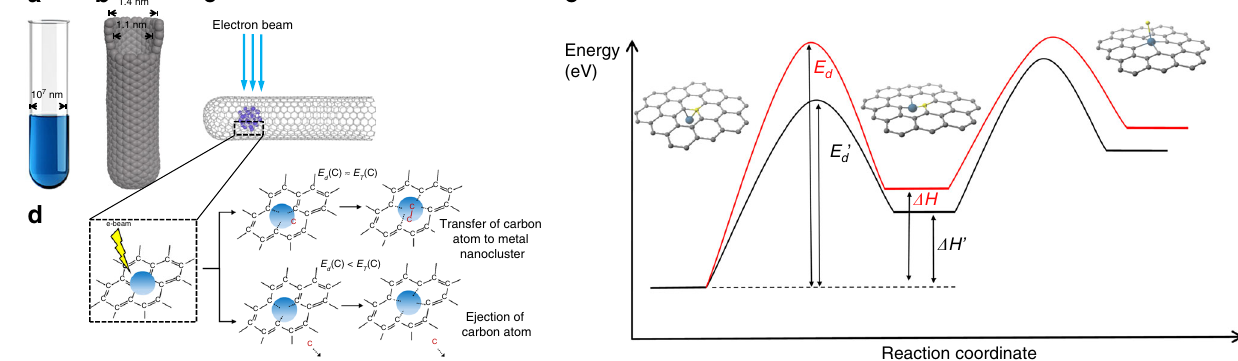
Fig. 1 Fundamental principles of ChemTEM. In comparison to conventional glass test tubes ( a ), which have a diameter of (cid:2) 1 cm (10 7 nm), carbon nanotubes ( b ), possess a channel with a van der Waals diameter of 1.1 nm making them a suitable vessel for the entrapment of nano-sized samples of different chemical elements, that can also act as an effective nanoreactor provided that the nanotube structure is not defective and its inner channel is free of impurities. Our methodology enables the insertion of clusters of 20 – 60 metal atoms within nano test tubes ( c ) and investigation by aberration corrected high resolution TEM (AC-HRTEM) reveals the nanoclusters ’ structures and chemical transformations at the atomic scale. The electron beam serves a dual purpose: some electrons (a tiny fraction) transfer a portion of their kinetic energy to the metal and carbon atoms, as described by the equation for E T above, which activates chemical transformations in the sample, whilst most of the electrons are transmitted through or scattered by the specimen generating two- dimensional images, the collation of which into time series enables the results of the induced transformations to be observed over time. d The presence of metal nanoclusters reduces the energy barrier for the displacement of a carbon atom ( E d ) from the nanotube which can be either ejected, leading to a vacancy defect (bottom diagram) or converted into another carbon structure (top diagram), with both processes facilitated by the metal nanocluster (Supplementary Fig. 9). e A schematic energy pro fi le of the formation of a vacancy defect illustrating a link between E d and the enthalpy change ( Δ H ): the formation of metal-carbon (M – C) bonds between the metal nanocluster (represented by a single metal atom) and the dangling bonds of the defect make the defect more stable, thus lowering the energy threshold for defect formation (black curve) as compared to the same process in the absence of a metal nanocluster (red